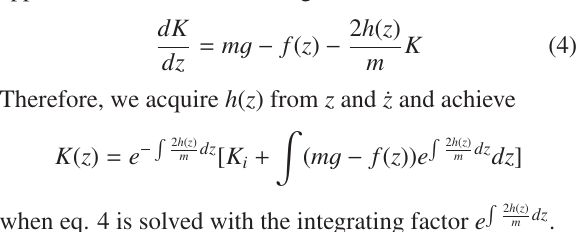
(cid:2) h ( z ) dz versus